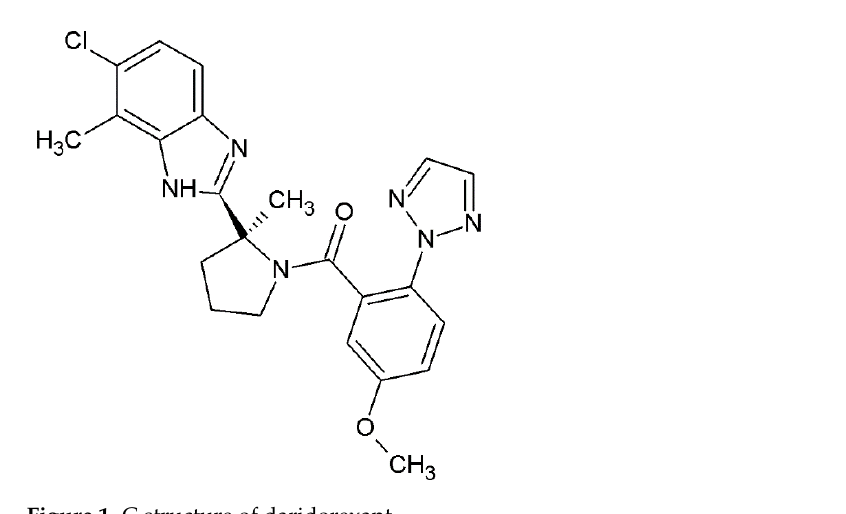
Figure 1. C structure of daridorexant.